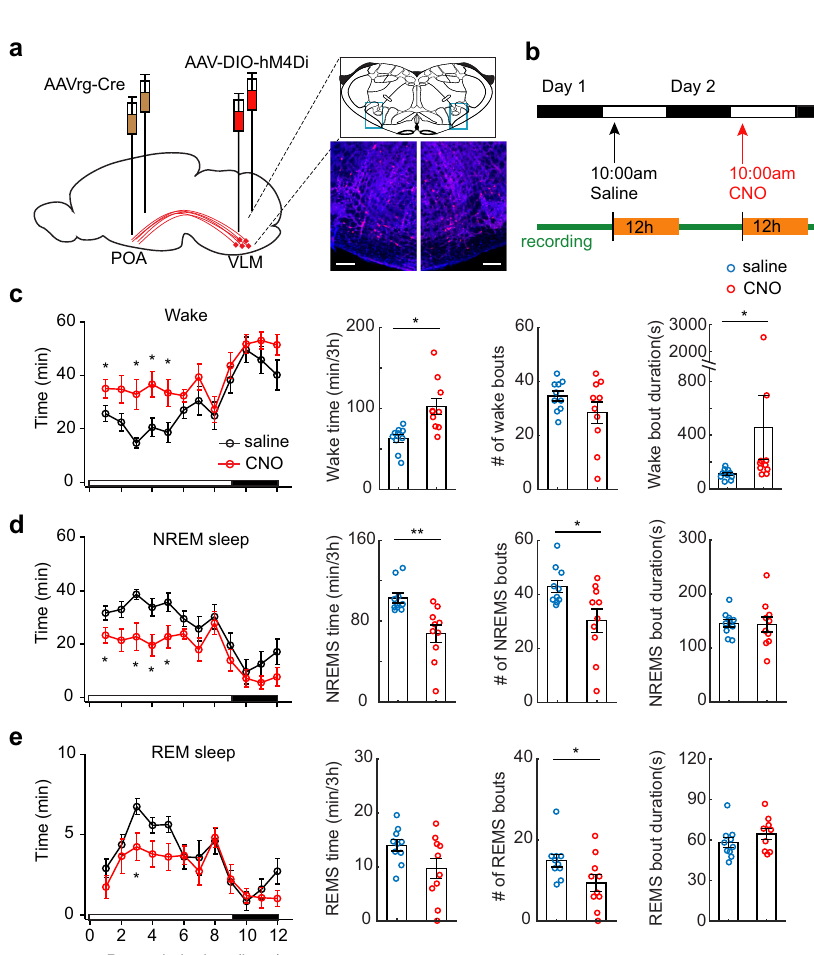
Fig.5|SilencingPOA-projectingmedullaneuronsdisruptsthetransitionsfrom wakefulness to sleep. a Schematic of chemogenetic inhibition. AAVrg-Cre was bilaterally injected in the POA and AAV9-hSyn-DIO-hM4D(Gi)-mCherry was bilat- erally injectedin the VLM of wild-type mice. Right, Fluorescence imagesof coronal sections in the VLM (blue boxes above) showing bilateral expression of inhibitory DREADDs ( n =8 mice). Mouse brain fi gure adapted from Allen mouse brain atlas. Red, mCherry, Blue, DAPI. Scale bars, 100 μ m. b Schematic of drug administration and sleep recording. c Wake time per hour over a12-h time window following CNO (1mg/kg,i.p.redcircles)andsaline(blackcircles)treatments.Right,quantitationof